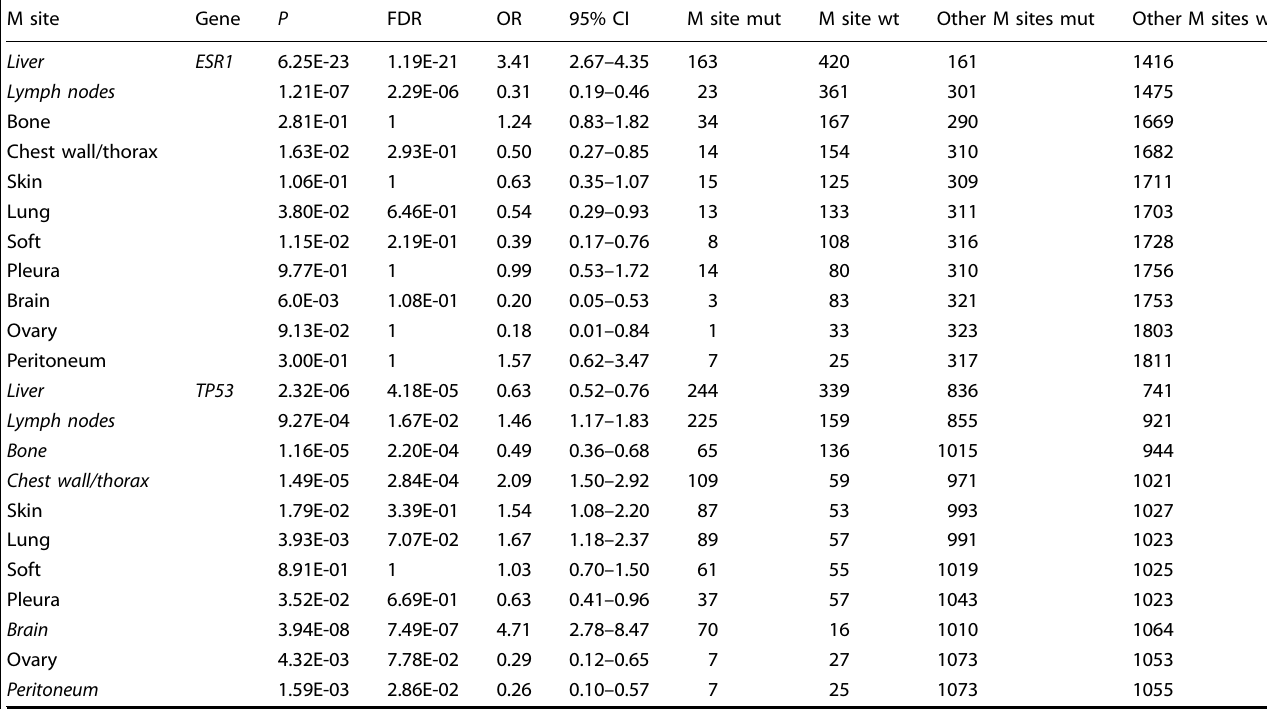
Table 2. Comparison of odds ratios of ESR1 and TP53 at various metastatic sites. M site